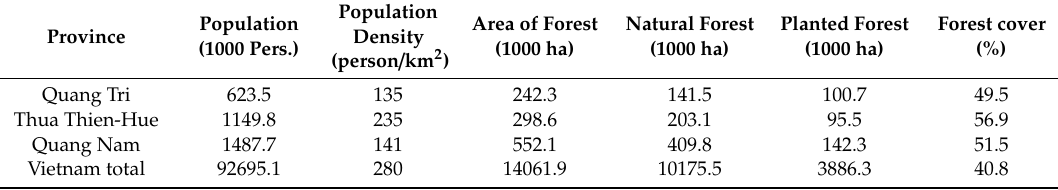
Figure 1. Location of the study communes. Table 1. Population, total area, and forest cover in the study provinces in 2015.